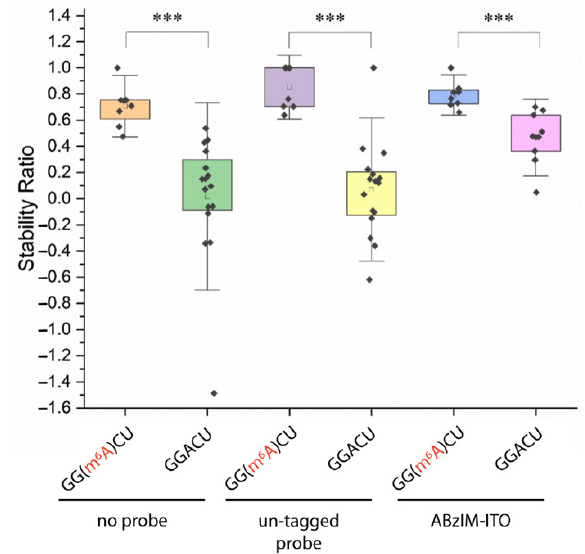
Figure 7. Comparison of stability ratios obtained from nuclease protection assays using 15-mer RNA standards possessing an m 6 A-modified or unmodified 5 ′ terminal consensus motif (GG(m 6 A)CU or GGACU). Within the box plots (25th to 75th percentile), the small square indicates the mean. Individual data points are represented by black diamonds. Error bars are 1.5 SD, unpaired t -test, *** = p < 0.001.